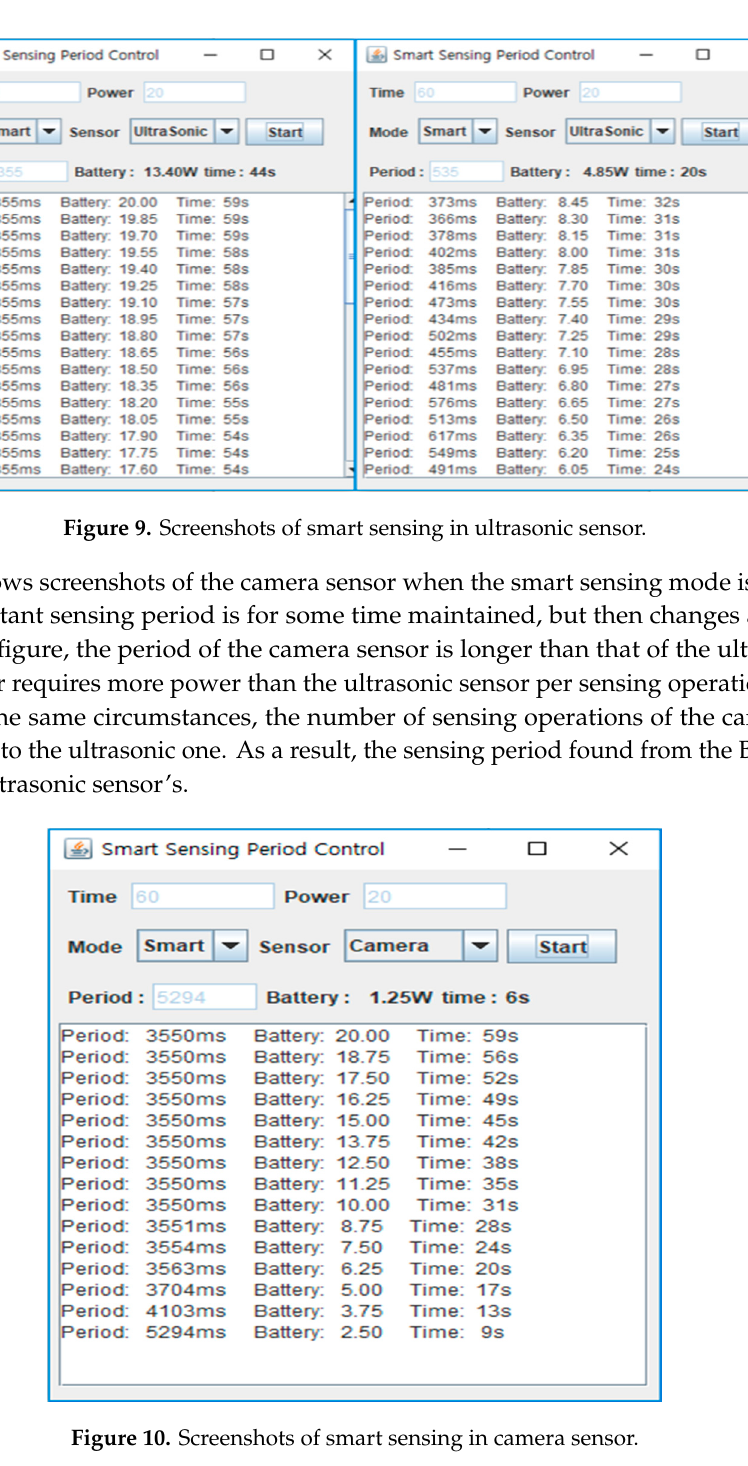
Figure 11. Power consumption of ultrasonic sensor in fixed sensing period.